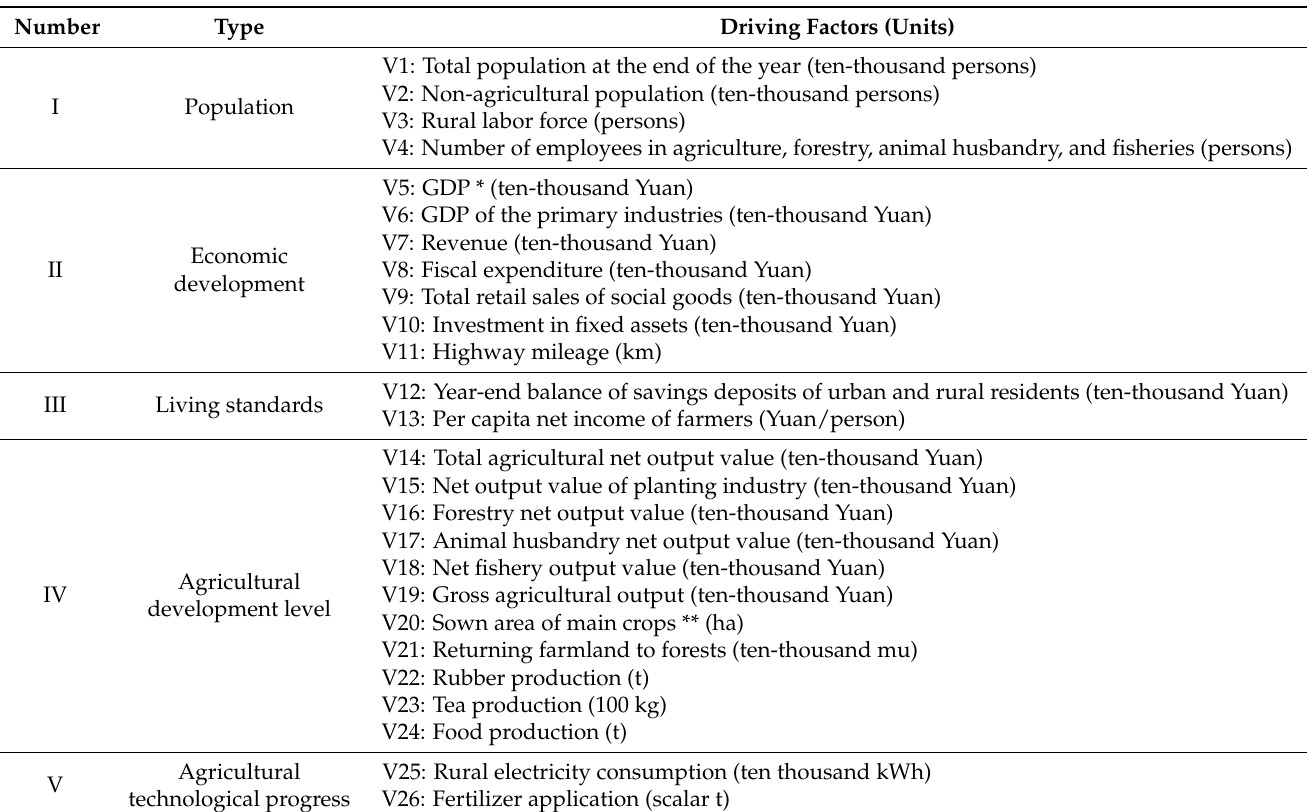
Table 1. Selection of socio-economic factors driving forest change in